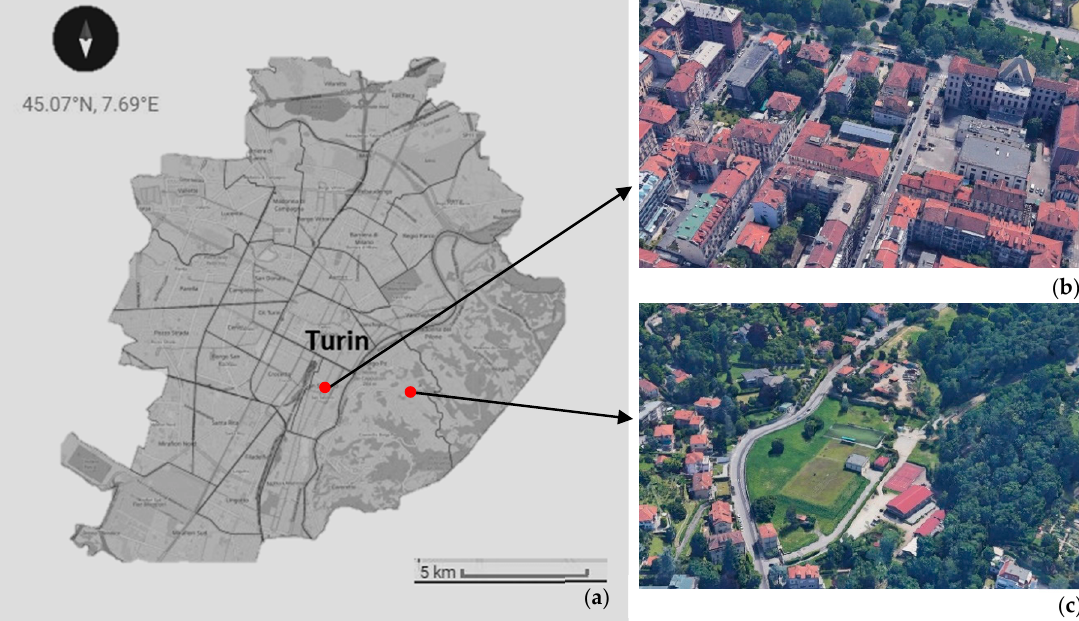
Figure 1. ( a ) Turin map and satellite (Google Earth) images of the considered sites: ( b ) Campana street garden (CA) and ( c ) Nobile Park (NOB).